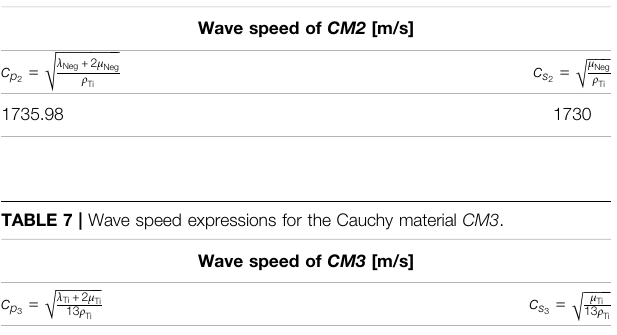
TABLE 6 | Wave speed expressions for the Cauchy material CM2 .